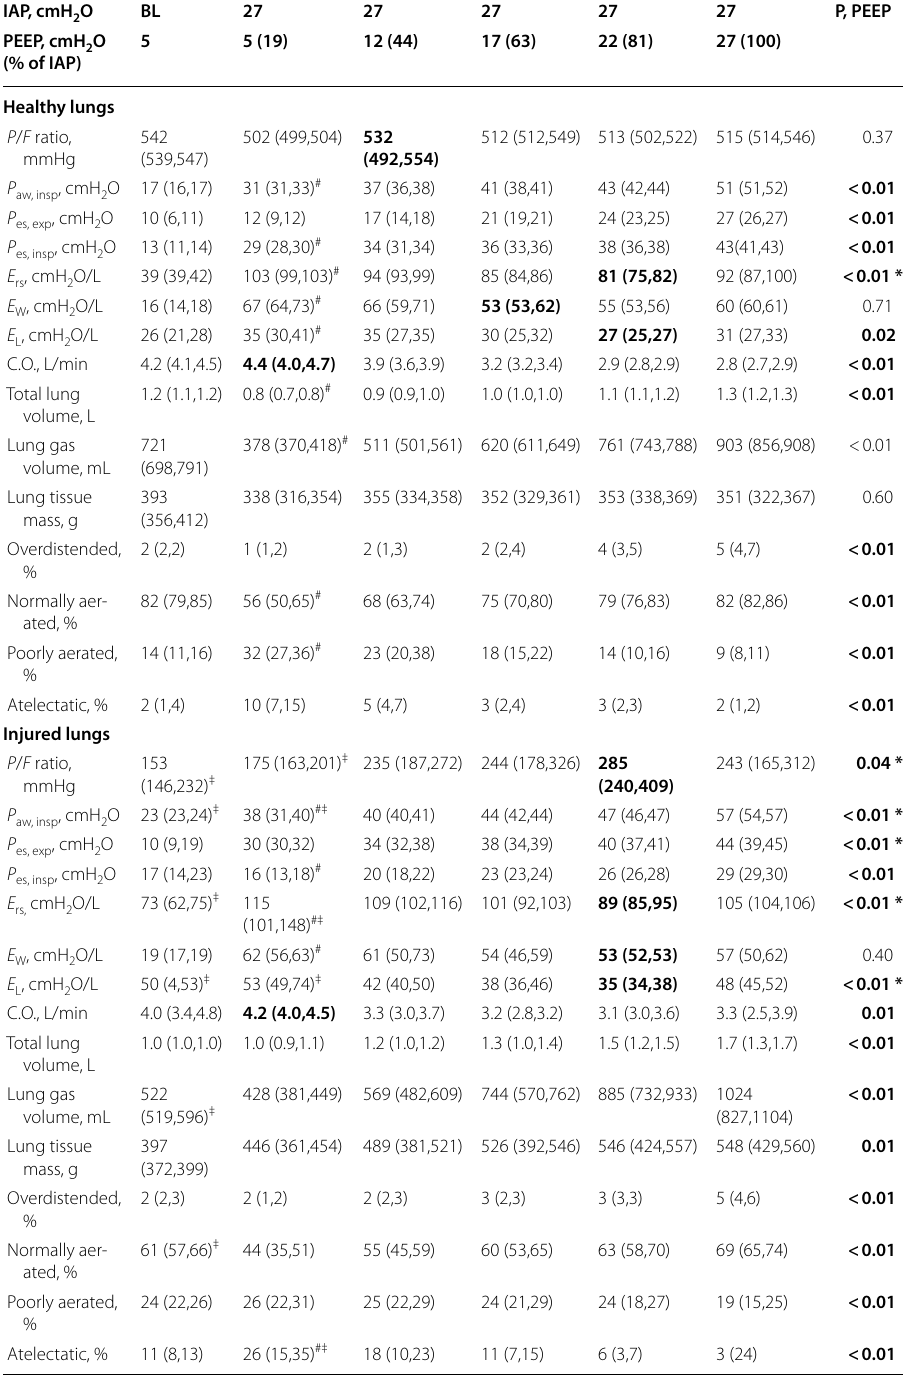
Table 1 Effect of PEEP on expiratory cardio‑respiratory